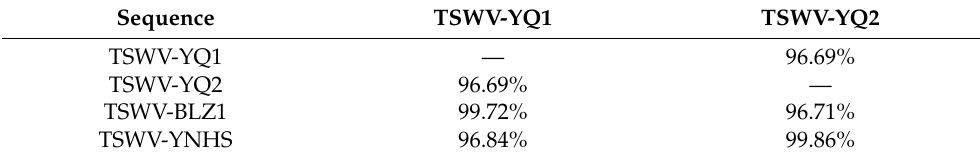
Table 1. Nucleotide sequence identity of TSWV N genes in 2020 and